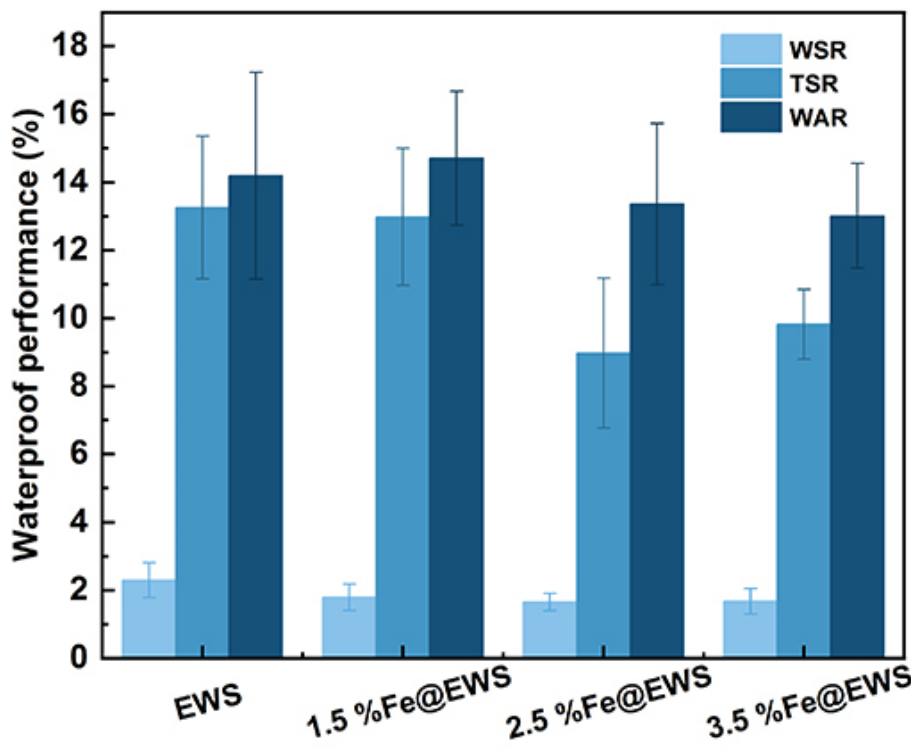
Figure 7. Water absorption rate, thickness swelling rate, and width swelling rate of EWS, 1.5%Fe@EWS, 2.5%Fe@EWS, and 3.5%Fe@EWS.